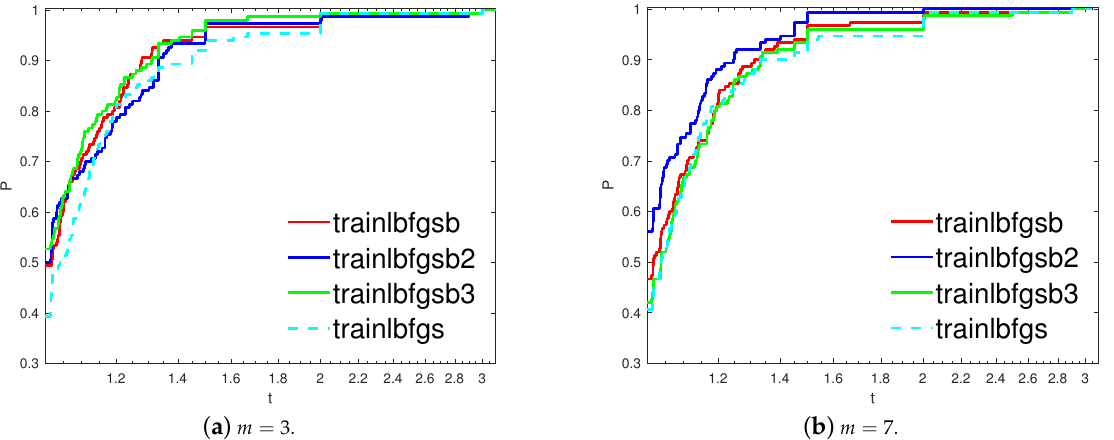
Figure 11. Log 10 scaled performance profiles based on accuracy for the SPECT heart classification problem.